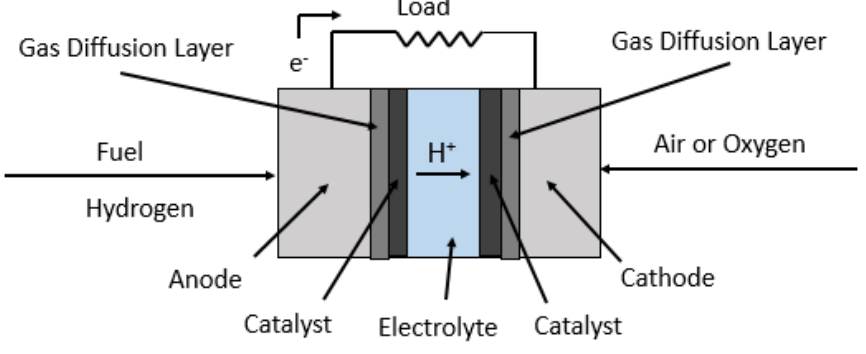
Figure 1. Fuel cell operation